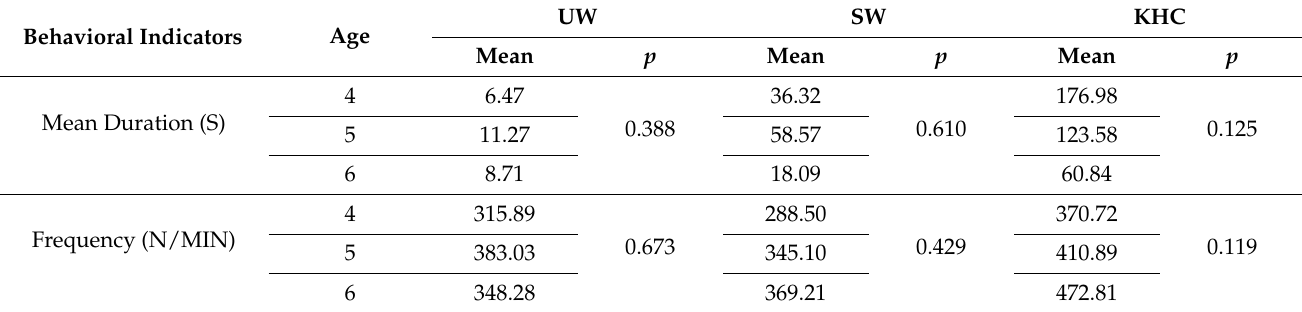
Table 5. Relationship among ages with motion-capture measures.